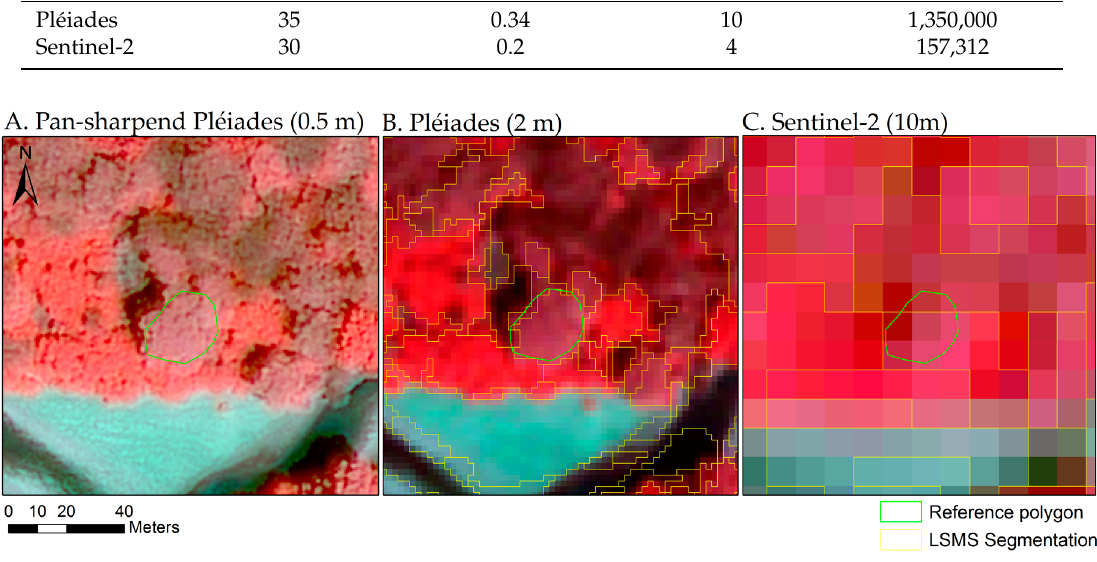
Table 4. Sensor-specific parameters used for creating the segmentation: Range Radius (RR), Spatial Radius (SR) and Minimum Size (MS). The resulting number of created segments is also indicated.